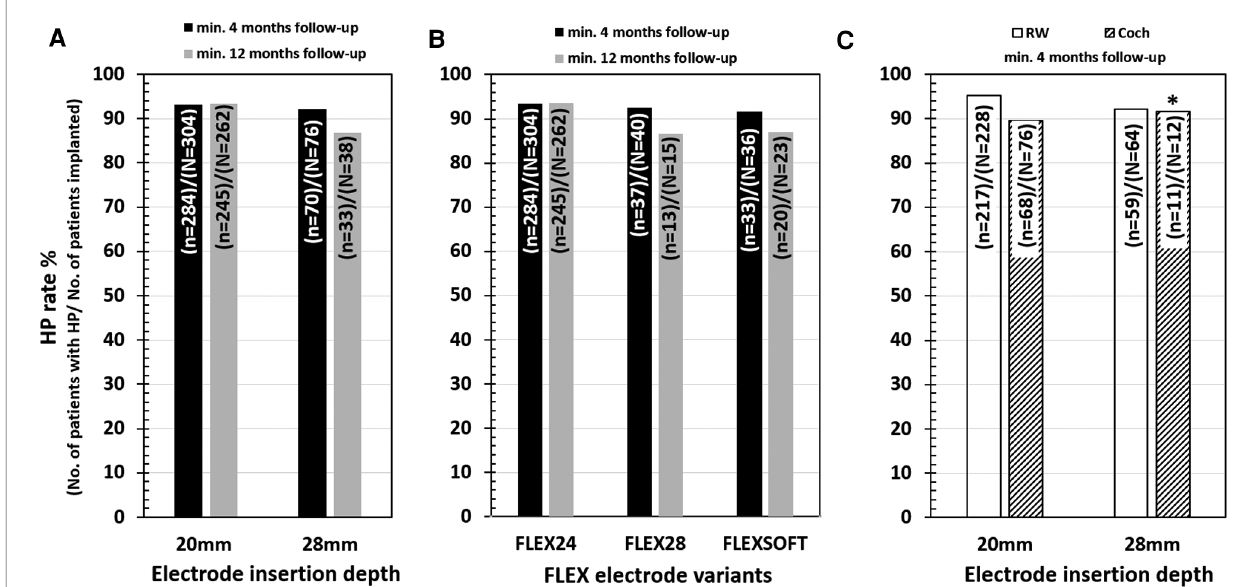
FIGURE 4 | HP rates for two different electrode insertion depths ( A ), of all three fl ex electrode variants ( B ) and at a minimum of 4-month and 12-month postoperative follow-up. HP rates for two different electrode insertion approaches at a minimum of 4-month follow-up ( C ). The “ N ” refers to the total number of patients implanted, and the “ n ” refers to the number of patients with HP. The 20 mm insertion depth refers to the medium-length FLEX24 implanted group, and over 28 mm of insertion depth refers to the longer FLEX28 and FLEXSOFT implanted groups. * points to the small number of patients in the cochleostomy group implanted with longer